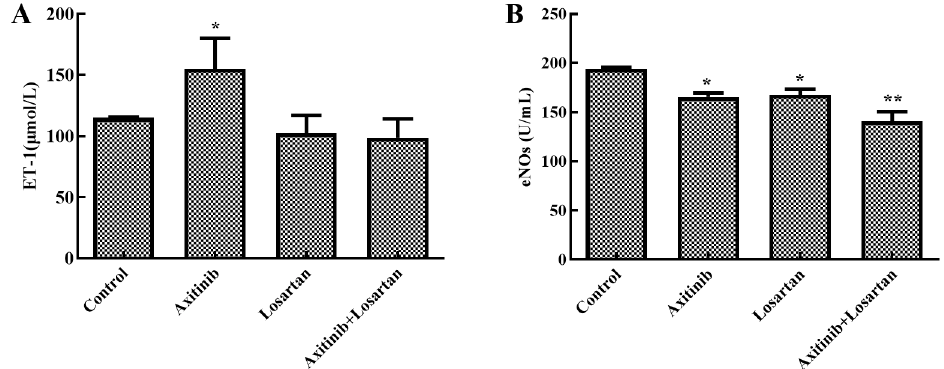
Figure 3. Effects of axitinib combined with losartan on endothelin function in rats. ( A ) Effects of axitinib combined with losartan on the level of endothelin-1 in rat serum. ( B ) Effects of axitinib combined with losartan on the level of eNOs in rat serum. * p < 0.05 vs. control. ** p < 0.01 vs. control.